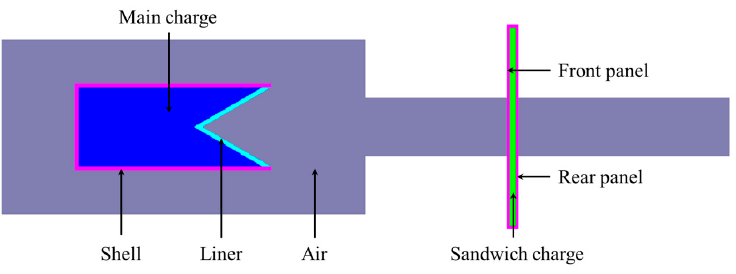
Figure 2. Finite element model.